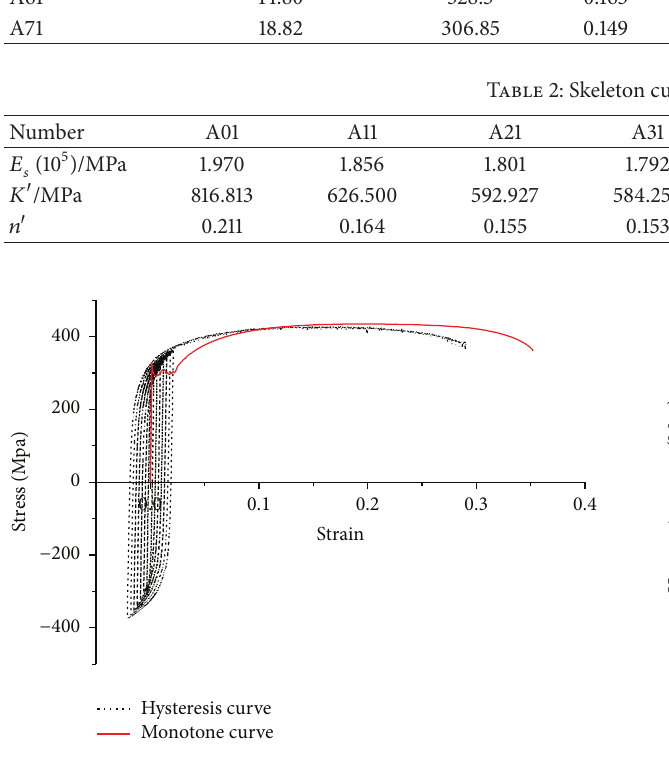
Figure 3: Comparison chart between monotonous and hysteresis curves.